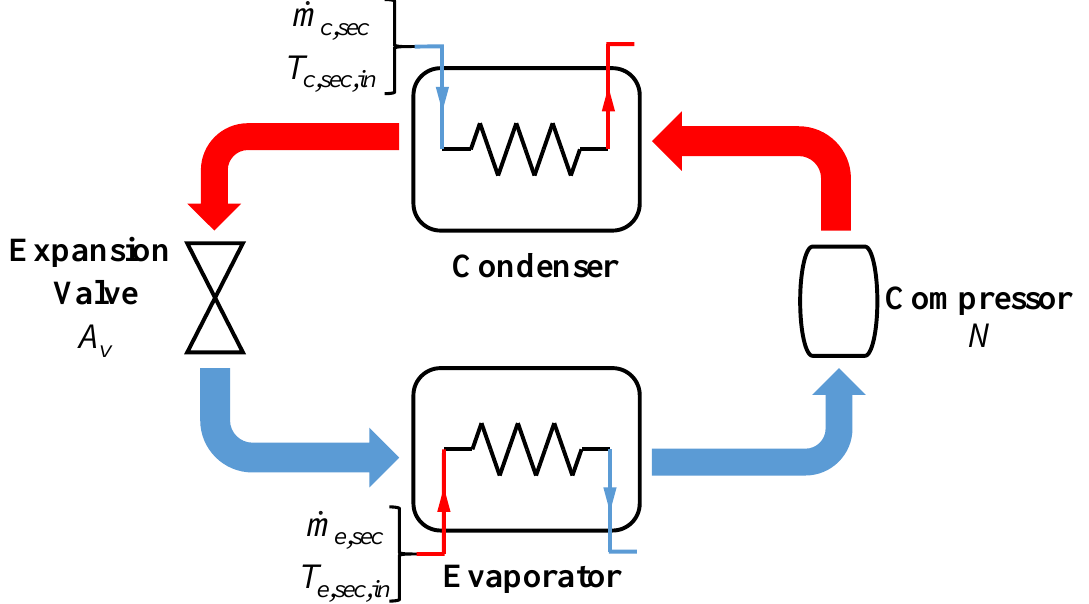
Figure 1. The composition of the refrigeration system. Table 1. Variables in the refrigeration system.